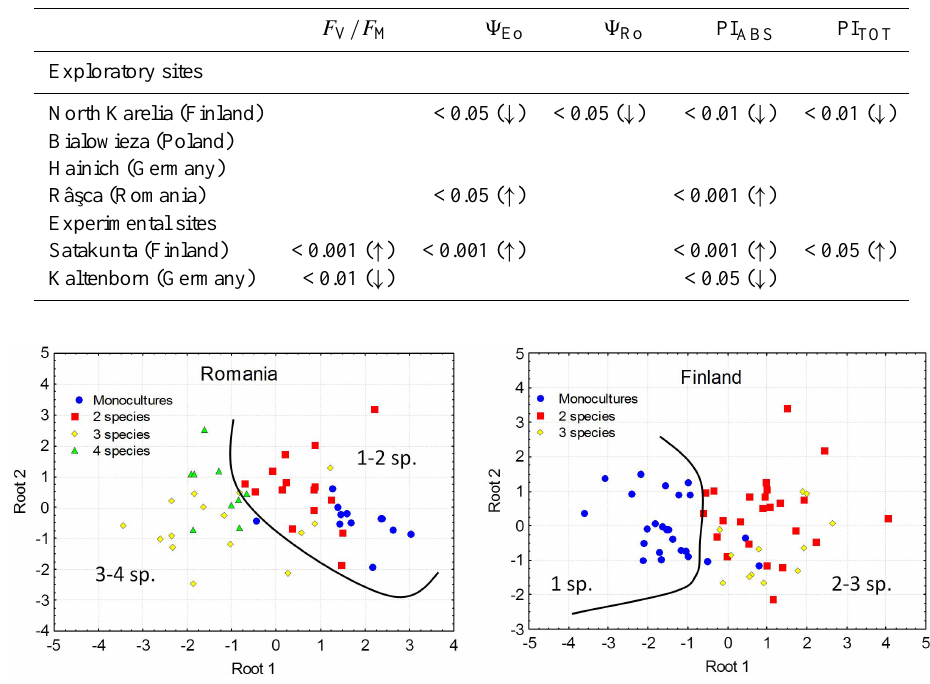
Table 1. Pearson correlation ( p values) of the OJIP-test parameters of spruce in relation to tree diversity in exploratory and experimental sites of the FunDivEUROPE project. Arrows indicate the direction of the correlation ( ↓= negative; ↑= positive). Significances of correlations are presented for p <0.05.